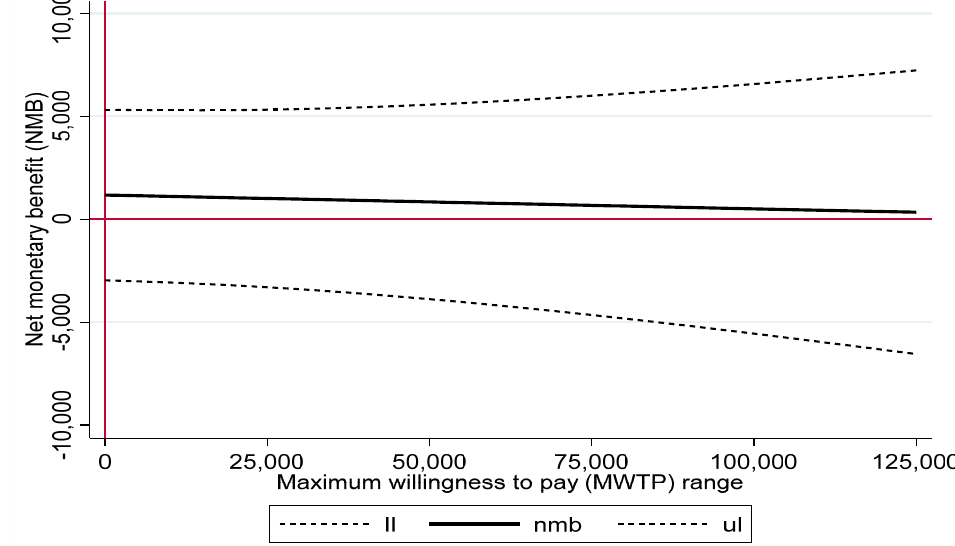
Figure 4. Net-monetary benefit regression curve. The solid black line indicates the net monetary benefit (nmb) in EUR which can be expected across the defined maximum willingness to pay range. The dotted lines indicate the upper and the lower limits of the 95% confidence interval of the nmb.